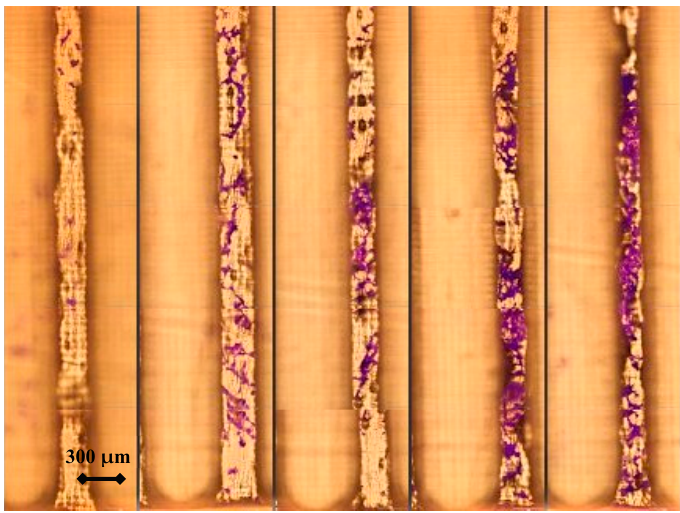
Figure 2. Results from the adhesion study of cells with growth factors cultured on the fractal microsystem: Cell distribution on the different channels showing the influence of channel geometry (microtexture) on cell adhesion. The roughness of the different channels increases from left to right.